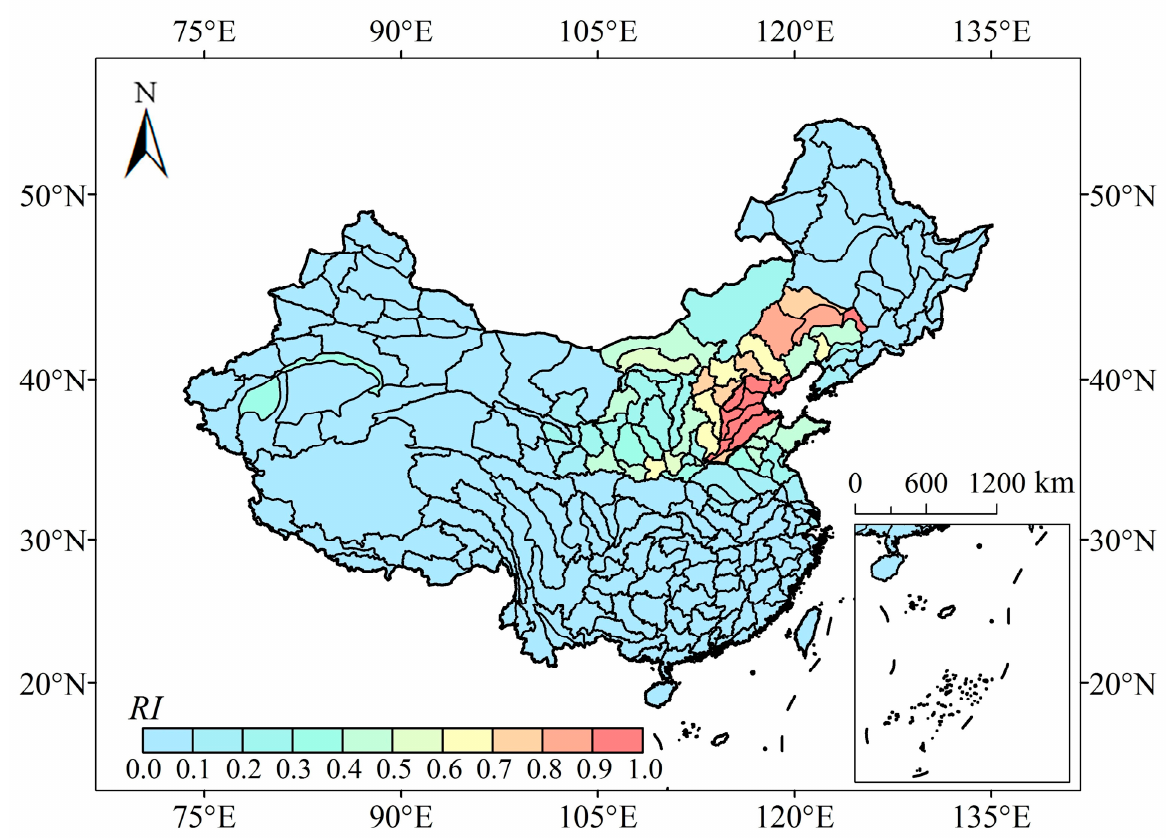
Figure 3. Map of the spatial distribution of water environment risk index ( RI ) in China. Figure 4 shows the spatial distributions of the six SCCs. R d increased from 0.00–0.05 km/km 2 in the northwest inland to above 0.09 km/km 2 in Southeast China, among which the R d in the estuary of the Pearl River and Yangtze River Deltas attained greater than 0.09 km/km 2 (Figure 4a). R w was higher on the east coast, especially in the plain area of the lower reaches of the Yangtze River, and in lake distribution areas such as the Qinghai Lake and the hinterland of the Qinghai-Tibet Plateau (Figure 4b). R d and R w have similar spatial distribution characteristics in the southeast China. The values of S r ranged from 0.0 ◦ to 13.2 ◦ in China and were the largest at the edge of the Qinghai-Tibet Plateau, while those were smaller in North China, Central China, the Northeast Plain, and the Middle-Lower Yangtze River Plain (Figure 4c). The longitudinal connectivity in the south was significantly weaker than that in the north, especially in the south of the Yangtze River Basin, with a maximum C l value of 1.76/100 km, which indicated the weakest longitudinal connectivity (Figure 4d). Simultaneously, the C l in the Yellow River Basin showed a spatial difference. The C c and R nc showed no significant regional differences in China and were relatively large in the Yellow River Basin, the Middle-Lower Yangtze River, and the estuary of the Yangtze and Pearl Rivers (Figure 4e,f) with the range, mean value, and variance of C c and R nc being 0.00–0.97, 0.30 and 0.18, 0.00–2.15, 1.11 and 0.47, respectively. Generally, R d , R w , and C l showed high values in the east and low values in the west, whereas S r showed a decreasing trend from the southwest to northeast. The spatial distributions of C c and R nc were relatively uniform in China. Additionally, the values of all six SCCs in some catchments in the western Northwest China were relatively high compared to that of the surrounding